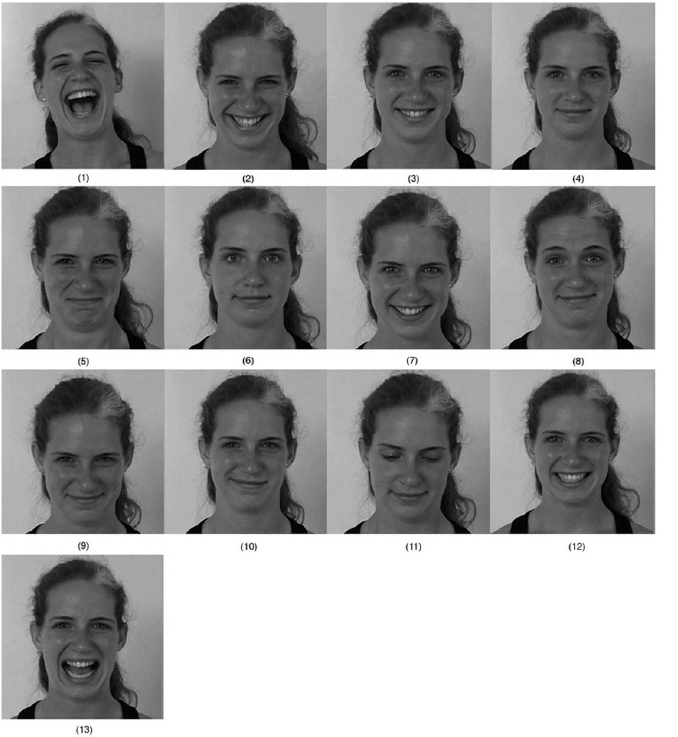
Fig 1. Laugh and smile taxonomy based on the different expressions of joy.